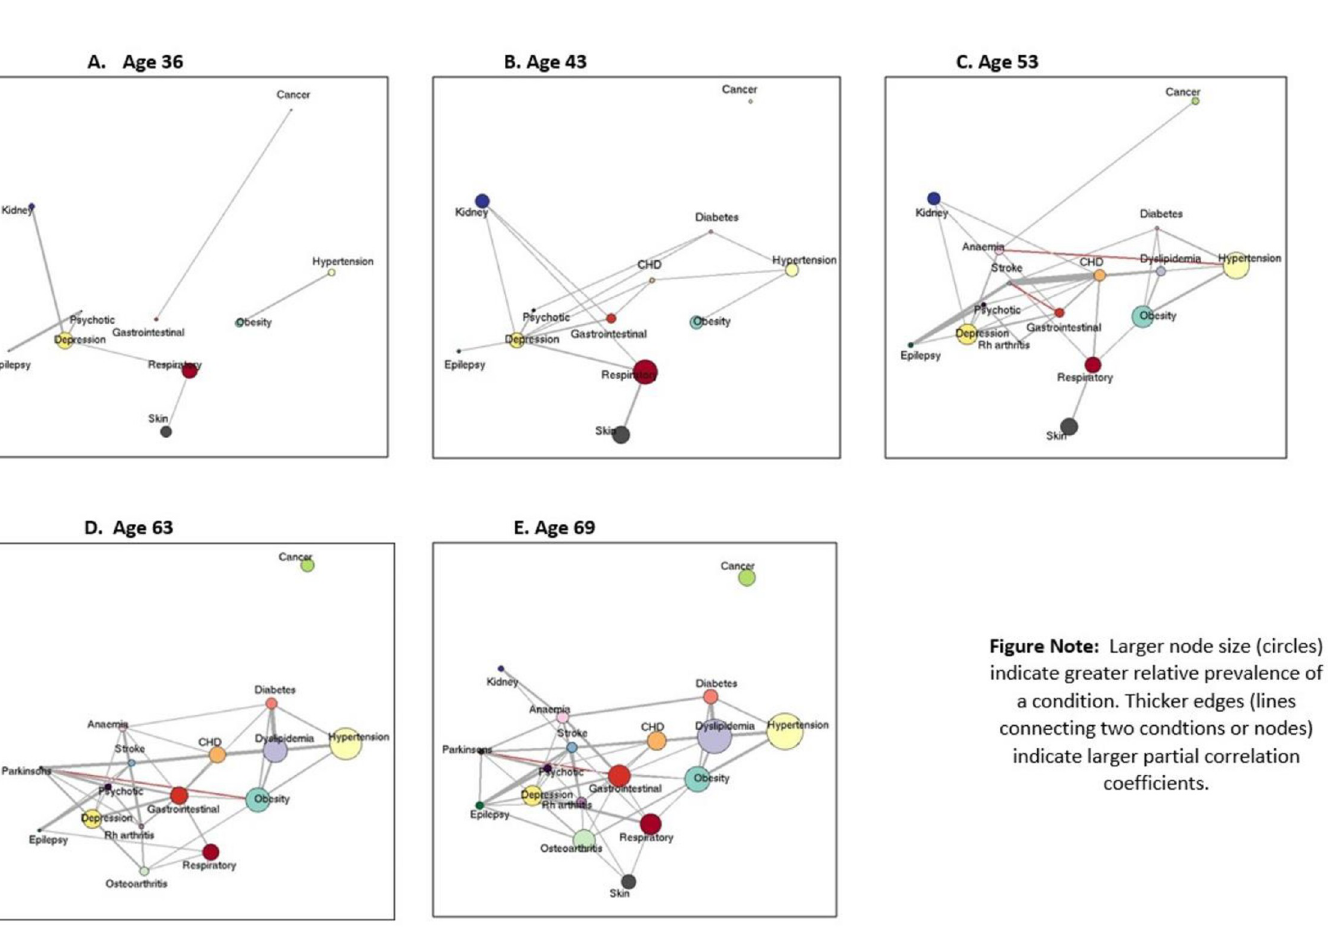
Fig 2. Network analysis illustrating relative prevalence (node size) of conditions and adjusted associations (edges) at each age in 3,723 participants from the 1946 MRC NSHD. CHD, coronary heart disease; NSHD, National Survey of Health and Development.